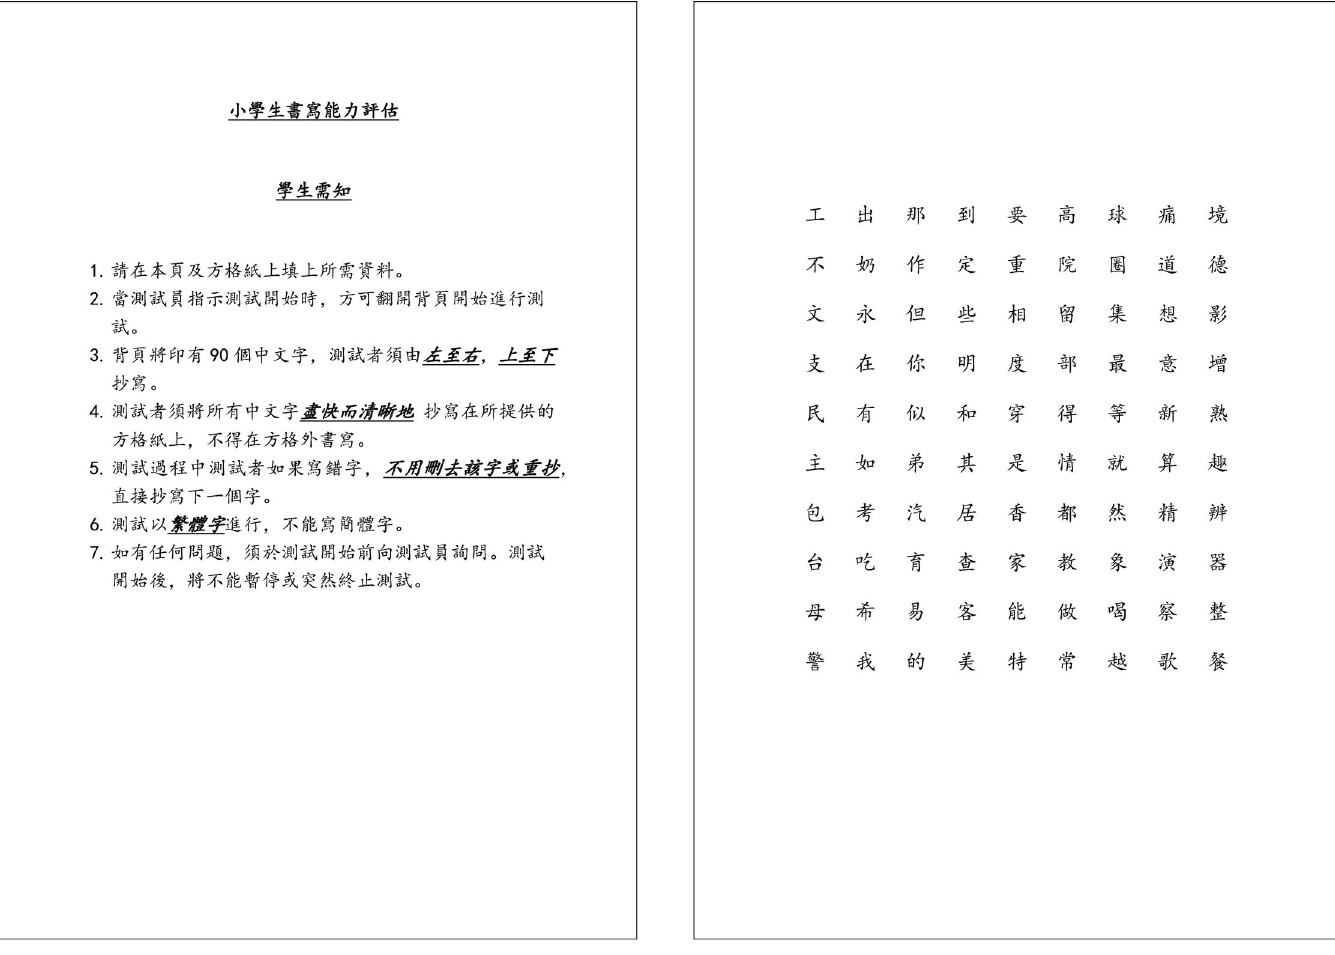
Fig 3. Handwriting assessment